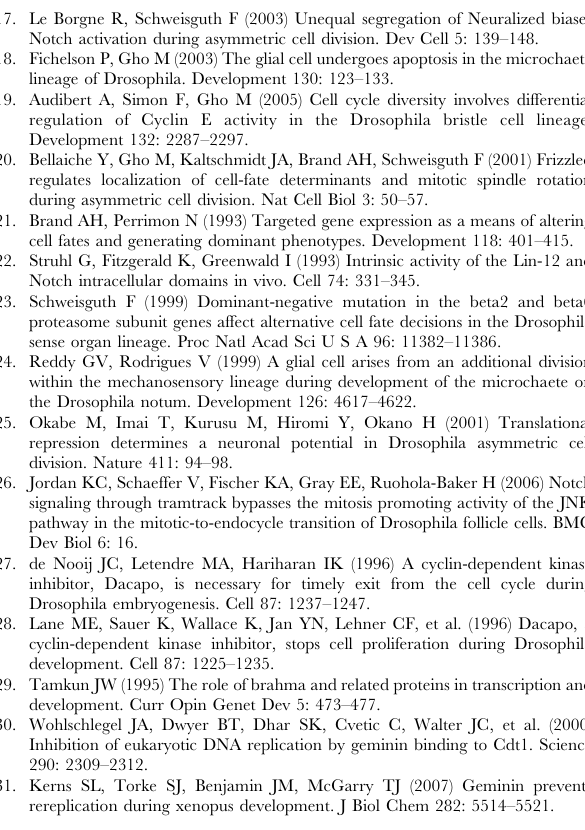
Figure S5 Numb blocks the N-response when was ectopically expressed within the first 30 min after pI division. A H2B::YFP/ HS-numb, neu . Gal4 pupae was heat shocked at a given time after pI division under time-lapse conditions. The formation of sensory organs composed exclusively of inner cells revealed the blockade of the normal N-response in the posterior secondary precursor cell (transformed lineage, ii). The plot shows the percentage of transformed lineages as a function of the time of HS application. Note that the overexpression of Numb effectively blocks the N- response only when the HS was applied during the first 30 minutes of